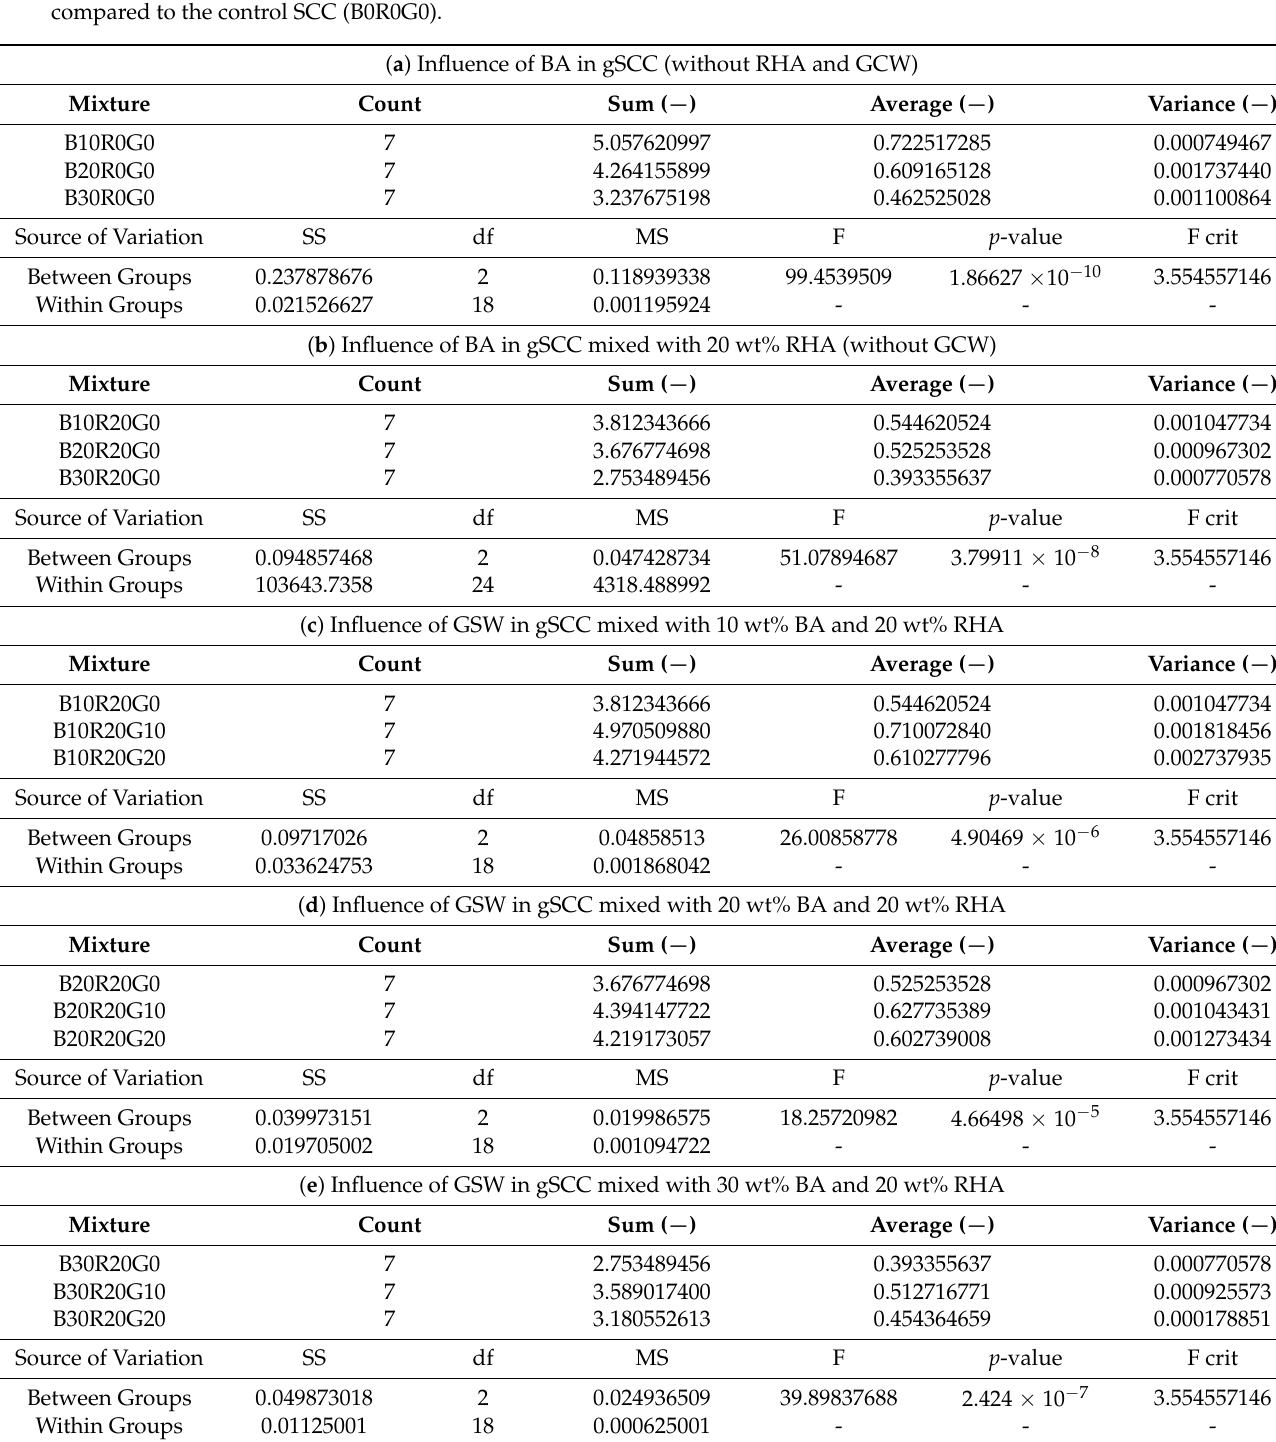
Table 6. Descriptive and one-way ANOVA analysis results at α = 0.05 obtained from normalized compressive strength compared to the control SCC